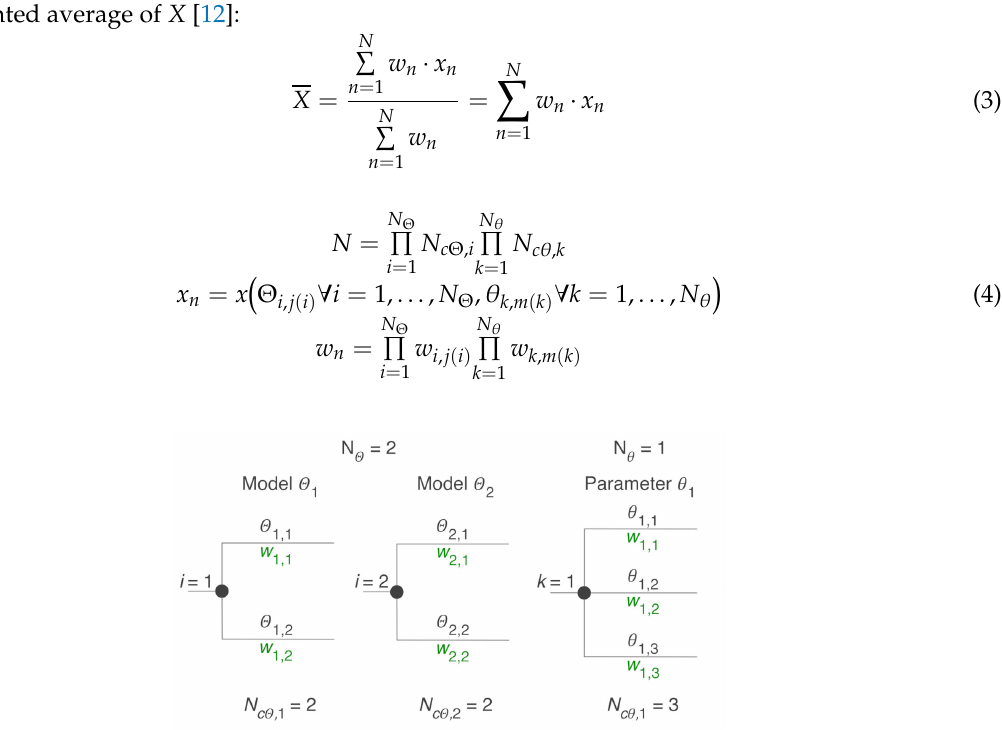
Figure 4. An example logic tree for a problem with two models and one uncertain model